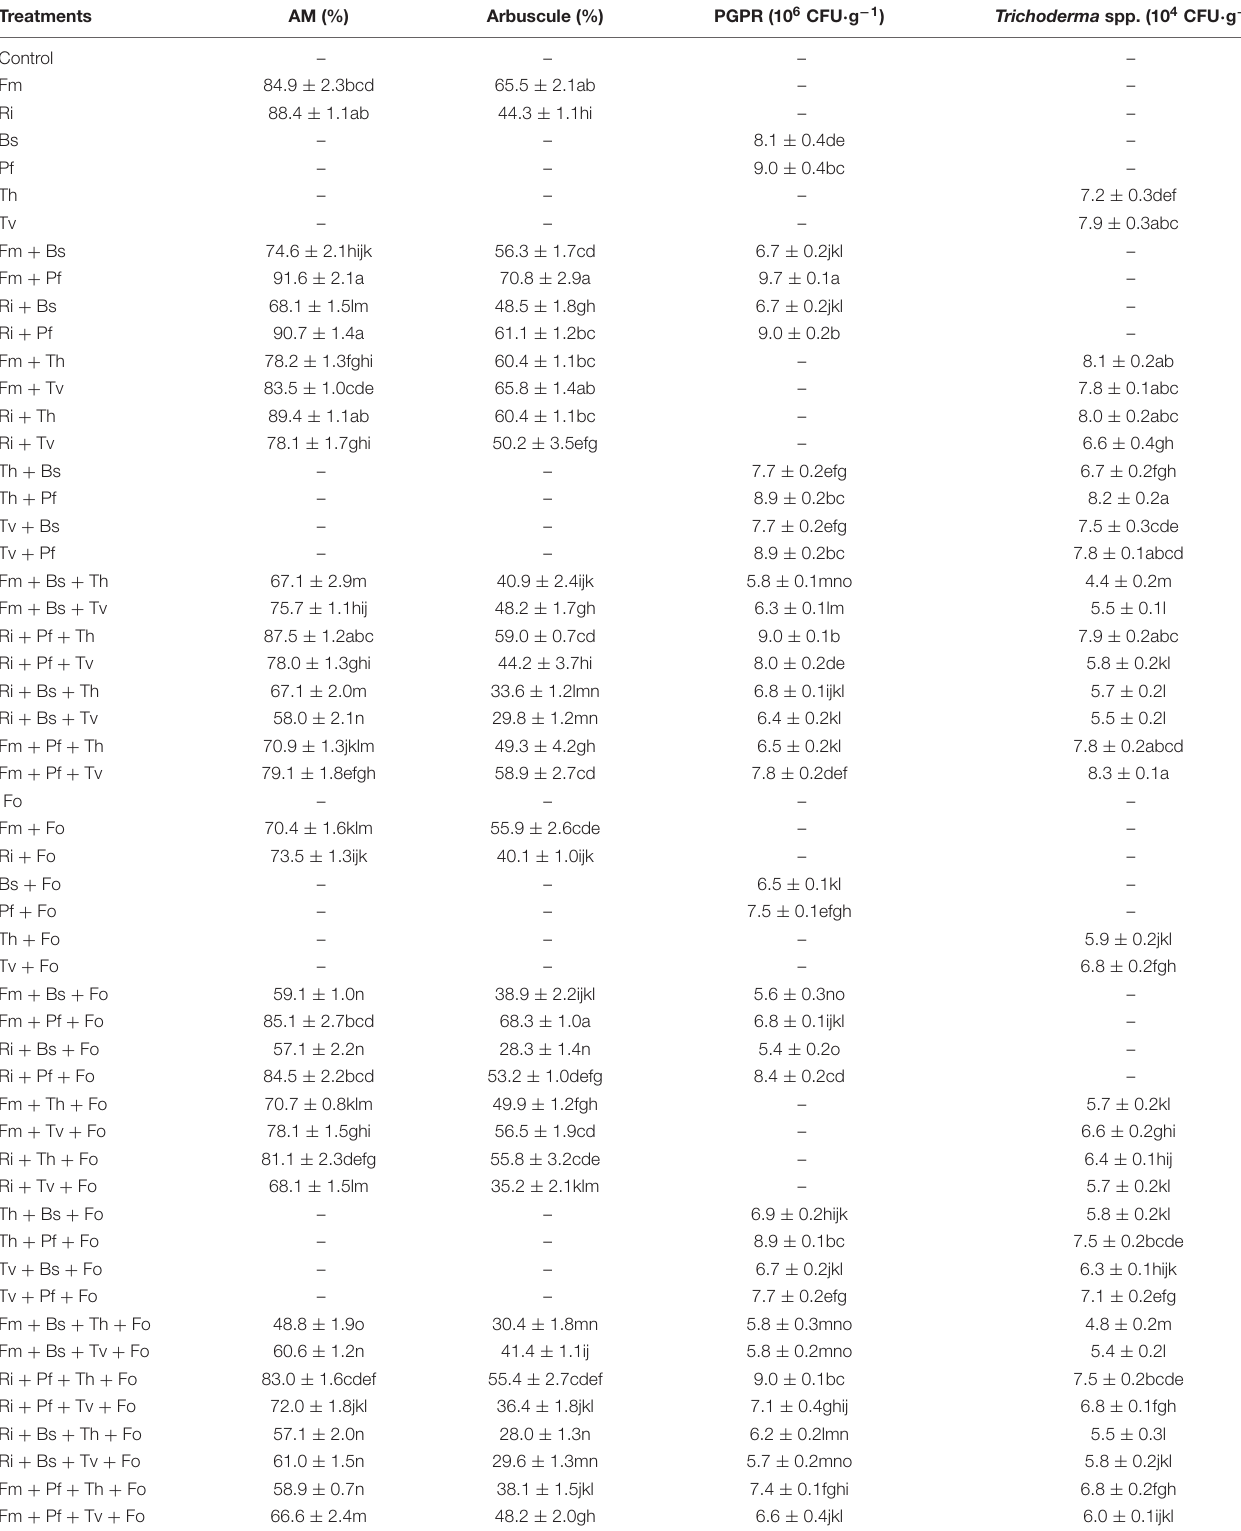
TABLE 1 | Colonization of AMF, PGPR, and Trichoderma spp. on tomato roots.